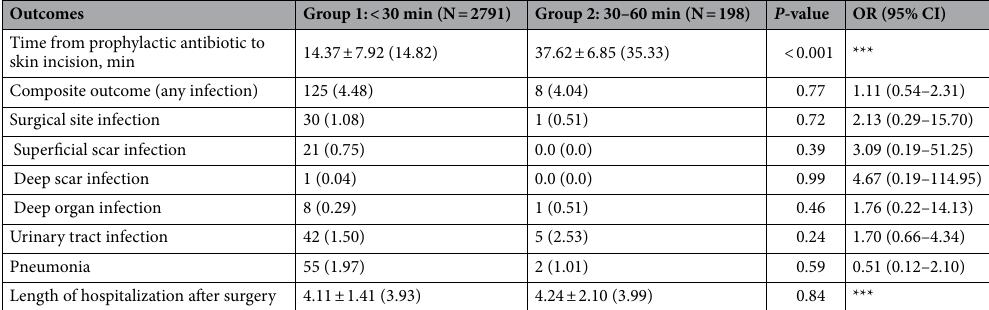
Table 3. Outcomes of women who received prophylactic antibiotic within 30 compared with 30–60 min before skin incision. Data are mean ± standard deviation (median) or N (%) unless otherwise specified.